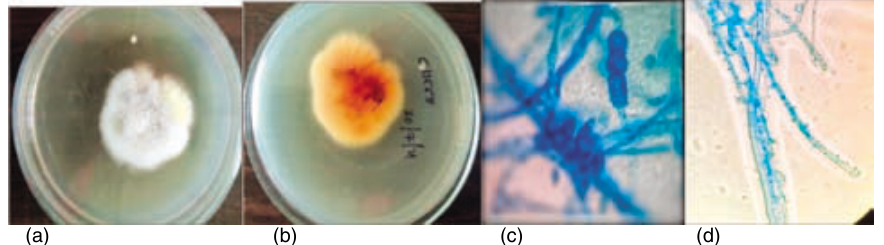
Fig. 3 . Epidermatophyton floccosum. a&b. Mustard yellow colonies with folded appearance; b. Four celled macroconidia